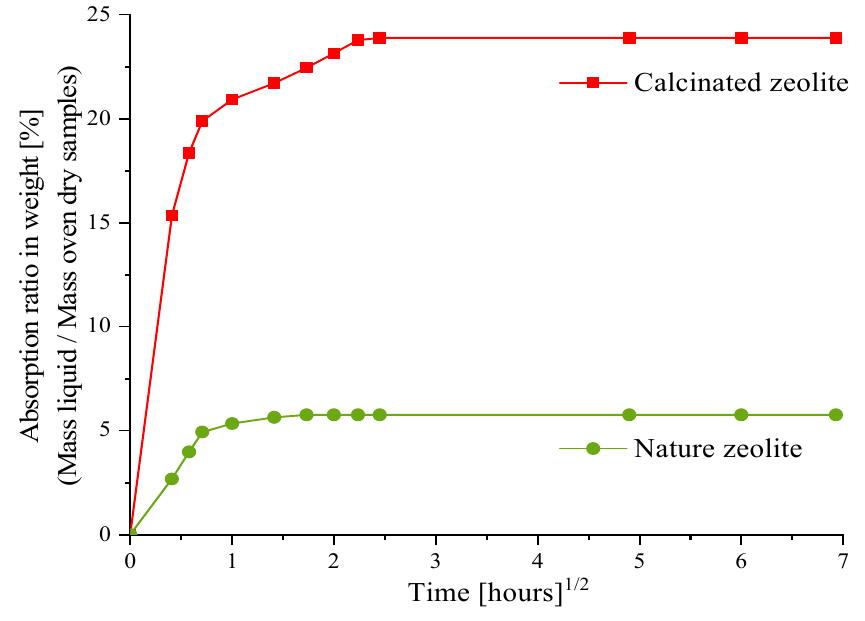
Figure 1. Square root of time vs. NaOH solution absorption of natural and calcined zeolite sand. All of the mix proportions of the AAS mortars are shown in Table 2. The mass proportions of slag, standard sand, and liquid were in a ratio of 1, 2, and 0.55, respectively, for all AAS mortars. In addition, the mixtures based on unity volume shown in the right side of Table 2 can be determined based on the mass and density of individual components of AAS mortar. Labels denoting NZ and CZ represent the internal curing of the AAS mortars with natural and calcined zeolite sand, respectively. The labels denoting a number represent the zeolite mass fraction of standard sand. A control group of AAS mortars without internal curing was labeled as AAS-0. The liquid-to-binder ratio (L/b) of the AAS mortar without internal curing (AAS-0) was 0.55. For the specimens containing zeolite sands, the basic l/b (corresponding to the liquid not absorbed by the zeolite) of the AAS with internal curing was the same as that of AAS-0. The additional liquid (absorbed by the zeolite sand)-to-binder ratio was marked as L/b IC . The total L/b of the AAS mortars with internal curing was the sum of the basic L/b and L/b IC , and the NaOH solution absorption of the natural and calcined zeolite sand was 5.58 and 23.80 wt.% of the dry zeolite mass. Therefore, the total l/b of AAS-NZ15, AAS-NZ30, AAS-CZ15, and AAS-CZ30 was 0.567, 0.584, 0.621, and 0.692, respectively. Ideally, similar to OPC systems, the replacement ratio of zeolite sand should be decided based on the needed internal curing water and absorption/desorption capacity. With the AAS system, it is difficult to find the theoretical needed “internal curing liquid.” In this study, zeolite sand’s replacement ratios (15% and 30%) were taken from reference [23]. In future studies, we will test the chemical shrinkage of AAS according to ASTM C1608 [28], and the results may be used in mixture design to quantify the LWA replacement ratio. The slag, standard sand, and pre-soaked zeolite sand were stirred using a mortar mixer at a low speed for 30 s. The NaOH liquid was added to all powders and stirred at a low speed for 2 min. Then, it was stopped for 30 s, and the under-agitated powder was scraped off of the mortar mixer’s inner wall. The mixing continued at a high-speed for another 120